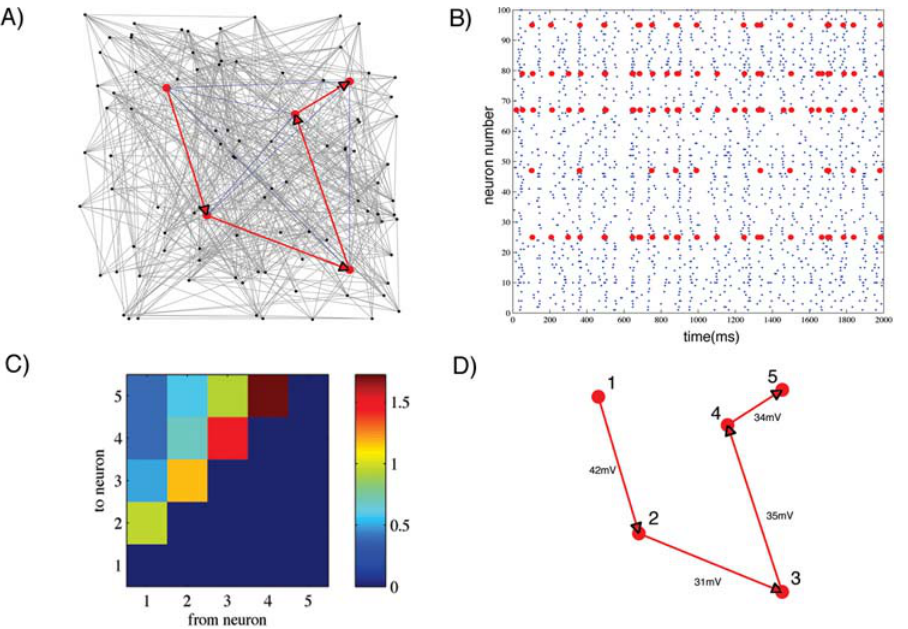
Figure 8. Recovery of Structural Information Using GC and CGC in a Biologically Plausible Complex 100-Neuron Network. A chain of 5 neurons (shown in red) is embedded within a larger network of 100 neurons connected in an all-to-all fashion (grey lines where only a fraction of the total connections are shown for clarity). The goal of this simulation is to extract the causal core shown in panel A using Granger Methods. Each synaptic weight in the chain is is set at 40 mV. Panel (B) shows the activity of these five neurons within the full network. Panel (C) shows the results from only PGC analysis in which the causal serial relationship can be seen along the diagonal. Panel (D) shows the remaining significant connectivity after CGC analysis and their corresponding synaptic weights. Note that the weights down the chain are significantly underestimated, this is likely due to the influence of the rest of the network on recovered weights.